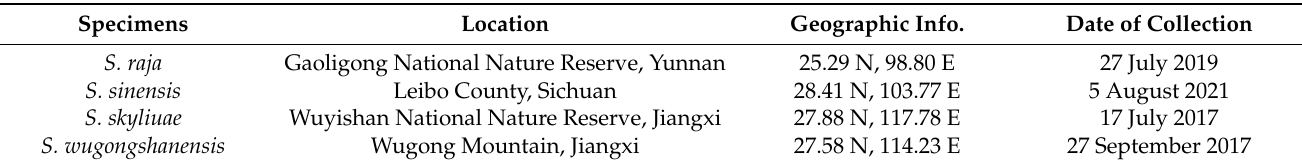
Table 1. Voucher information of the specimens used for mitochondrial genomes